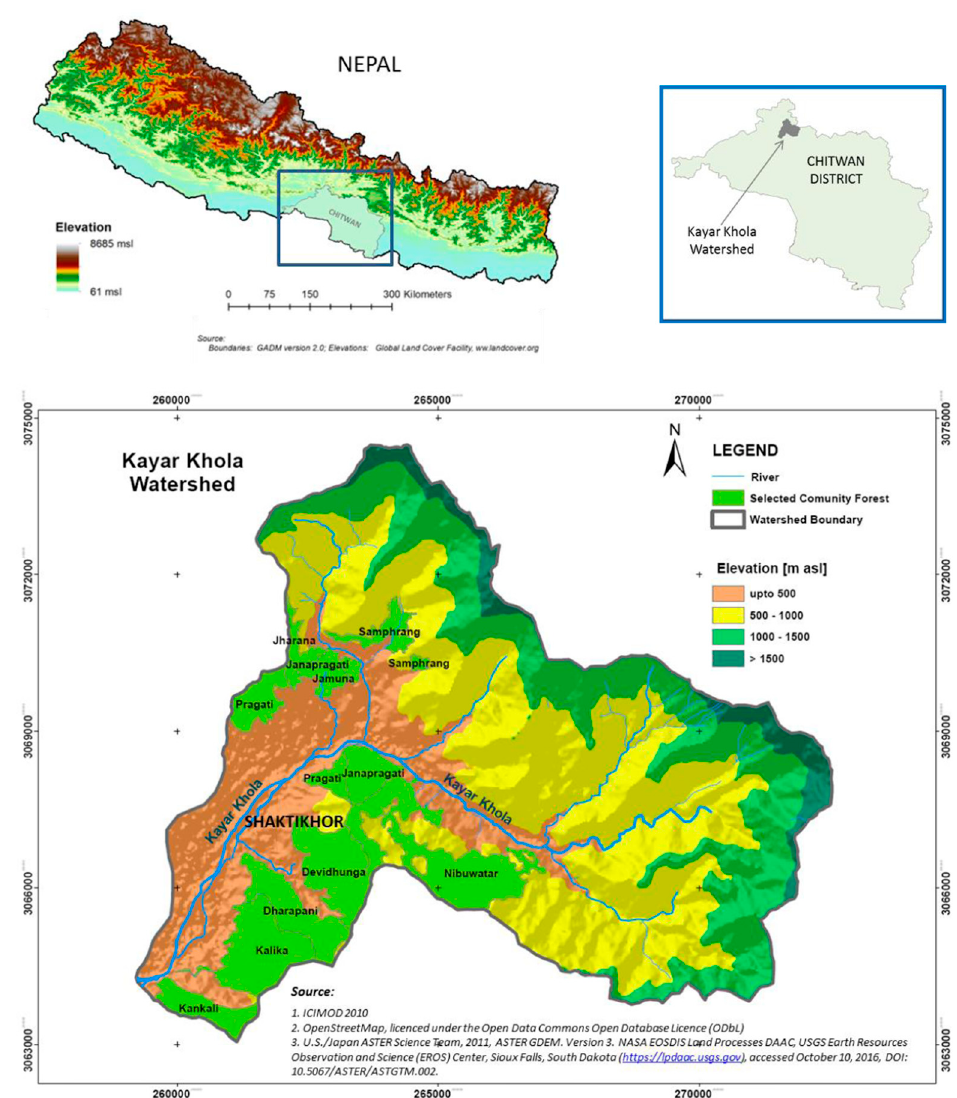
Figure 1. Location and geographic context of the study site in Nepal.